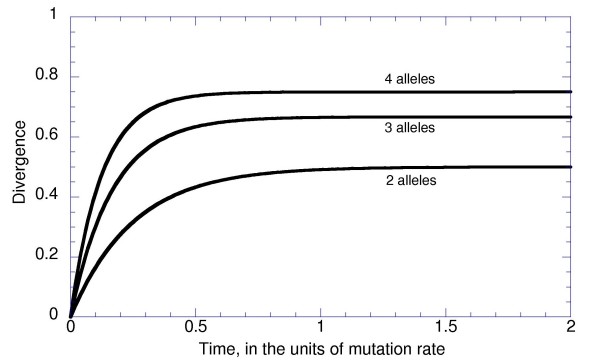
Dynamics of divergence of independently evolving sequences of 2-, 3-, and 4- allelic loci without selection.